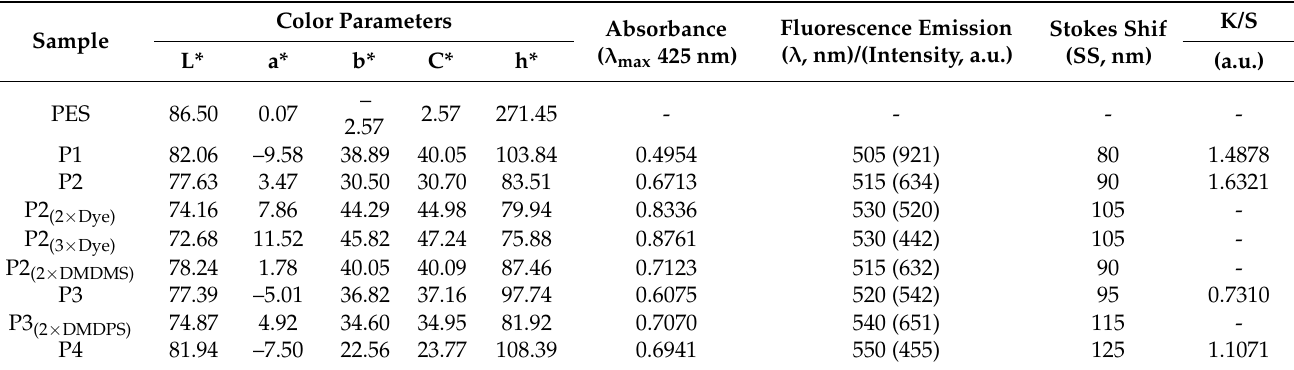
Table 3. Optical parameters of coated PES